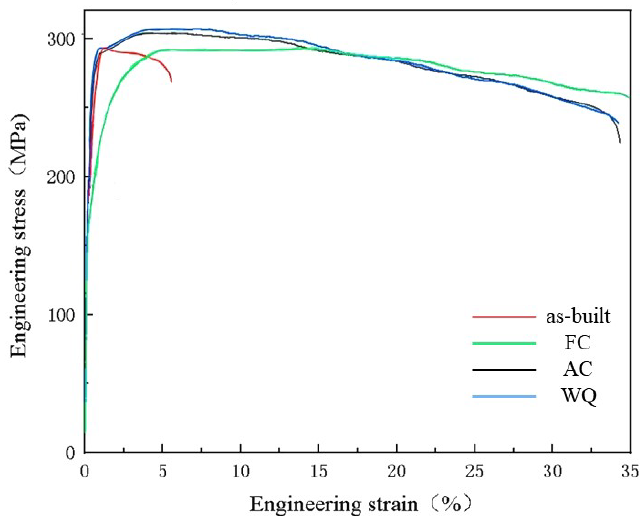
Table 3. High-temperature tensile results.